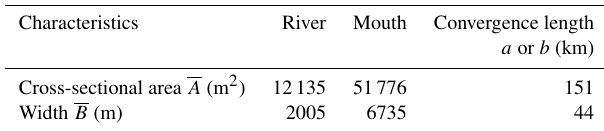
Table 2. Characteristics of geometric parameters in the Yangtze River